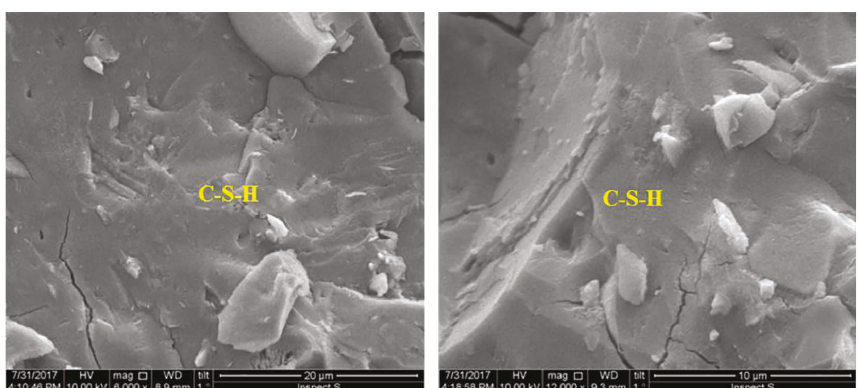
Figure 10: The SEM images for 90GMS geopolymer paste at 7 curing